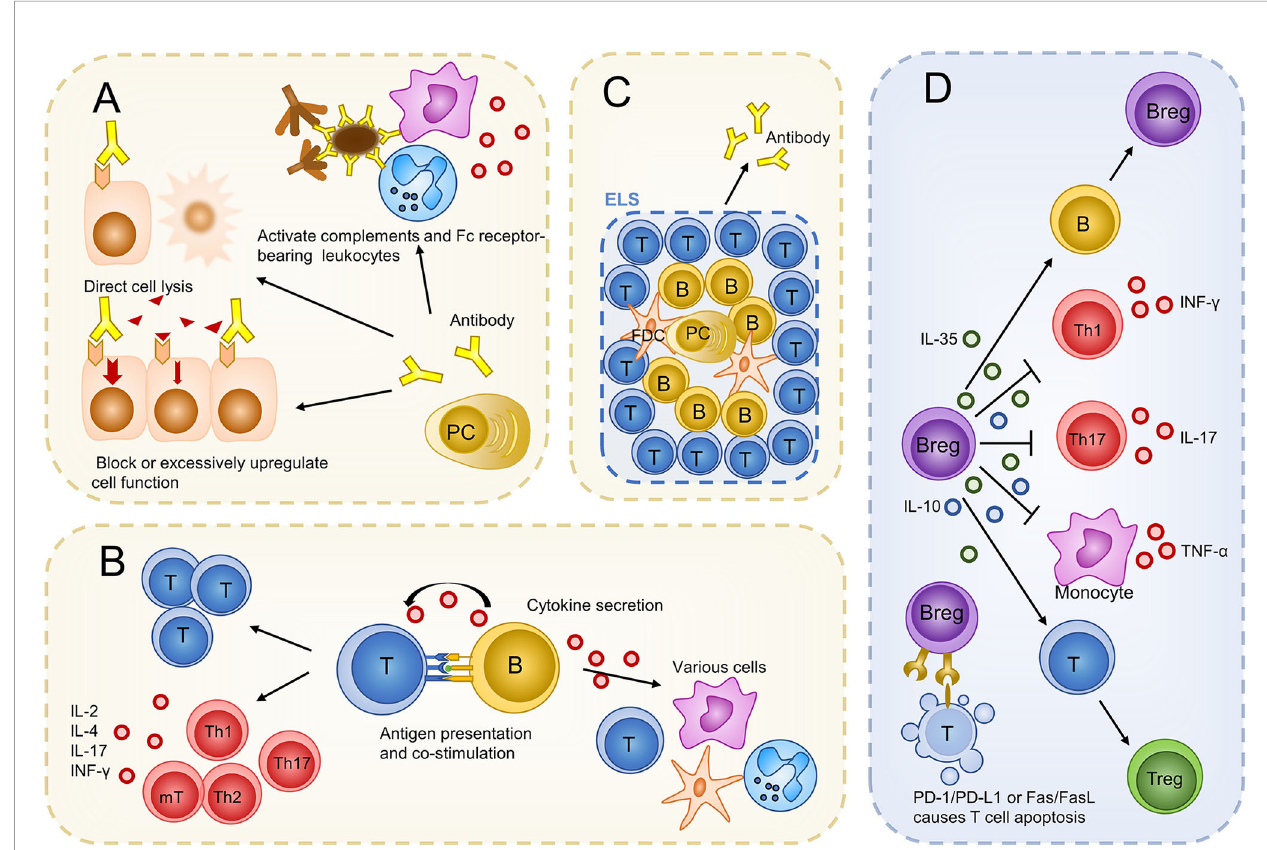
FIGURE 2 | Possible roles of B cells in non-infectious uveitis. B cells evolve into plasma cells and produce antibodies to promote in fl ammation and damage ocular tissues (A) . Via antibody independent functions, B cells regulate the proliferation and differentiation of T cells. Cytokines produced by B cells can also in fl uence other immune cells (B) . B cells constitute ELS to produce more autoantibodies (C) . Bregs regulate immunity mainly by producing IL-10 and IL-35. Bregs can also kill T cells via a PD-1/PD-L1 or Fas/FasL-dependent mechanism (D) . PC, plasma cell; T, T cell; B, B cell; mT, memory T cell; Th, T helper cell; FDC, follicular dendritic cell; Tfh, follicular helper T cell; ELS, ectopic lymphoid structures; IL, interleukin; PD-L1, programmed cell death-ligand